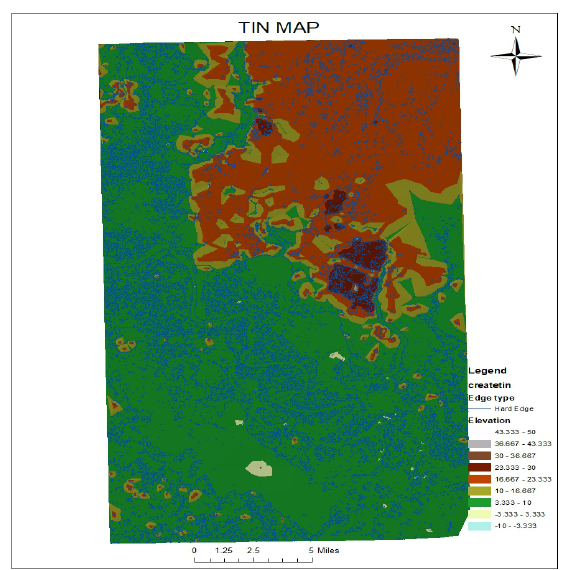
Figure.7. TIN Map showing high water accumulation over agricultural and urban low-lying areas